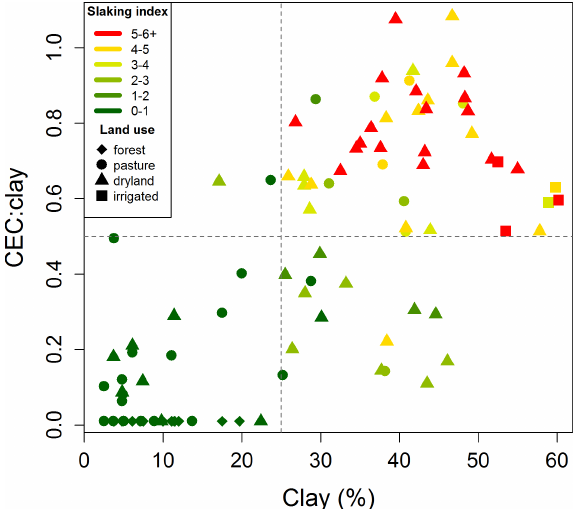
Figure 3. Relationship between clay content, CEC:clay ratio, and slaking index (SI). Land use at sample site is indicated as forest, pasture, dryland cropping, or irrigated cropping. Dashed lines indi- cate clay content of 25% and CEC:clay ratio of 0.5, above which extreme slaking was